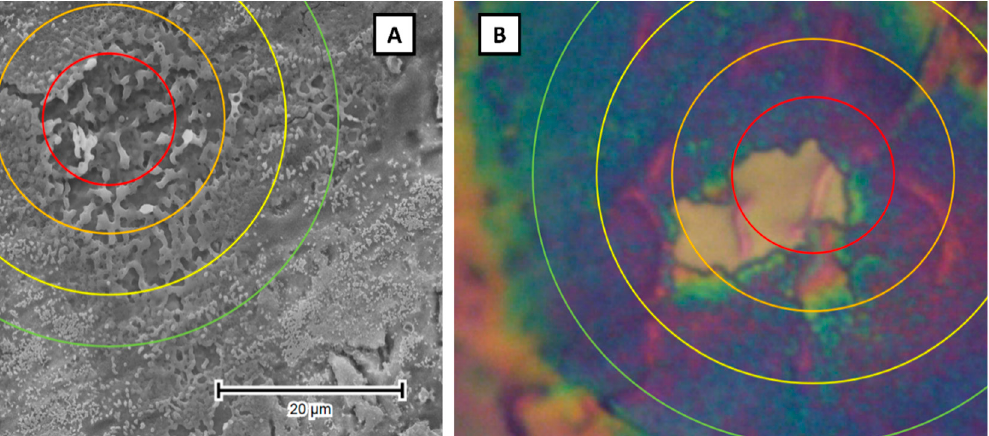
Figure 3. SEM ( A ) and optical ( B ) image of the hotspot of laser-modified titania nanotubes with the size of influence indicated.